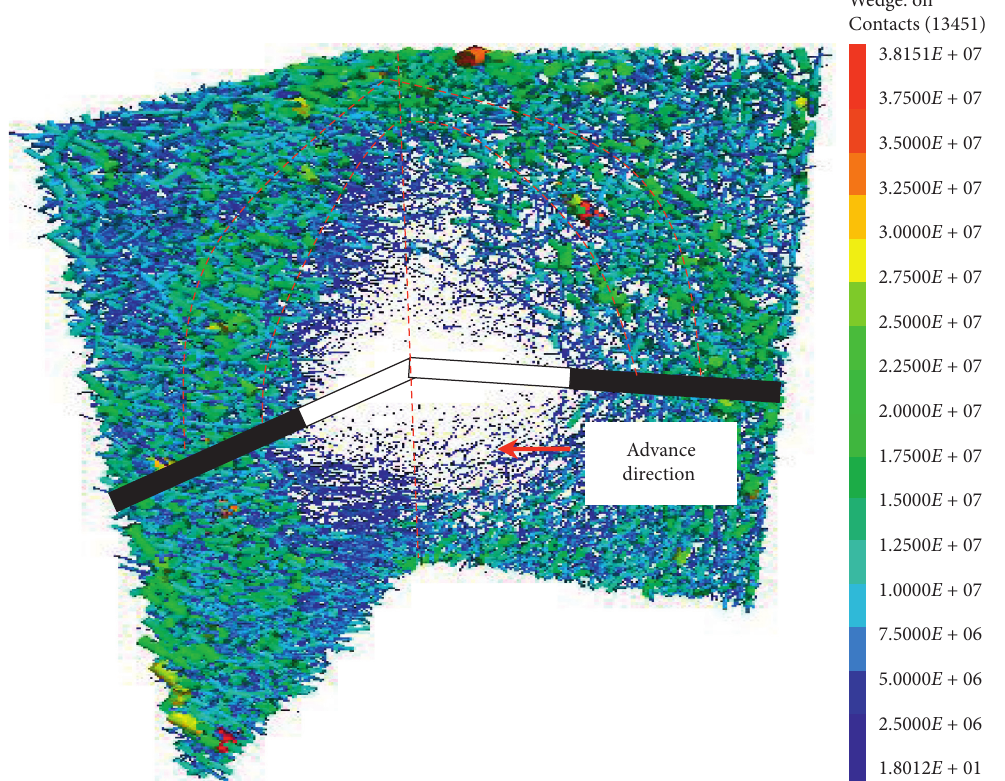
Figure 12: Three-dimensional spatial distribution characteristics of the force chains within the surrounding rock masses of the